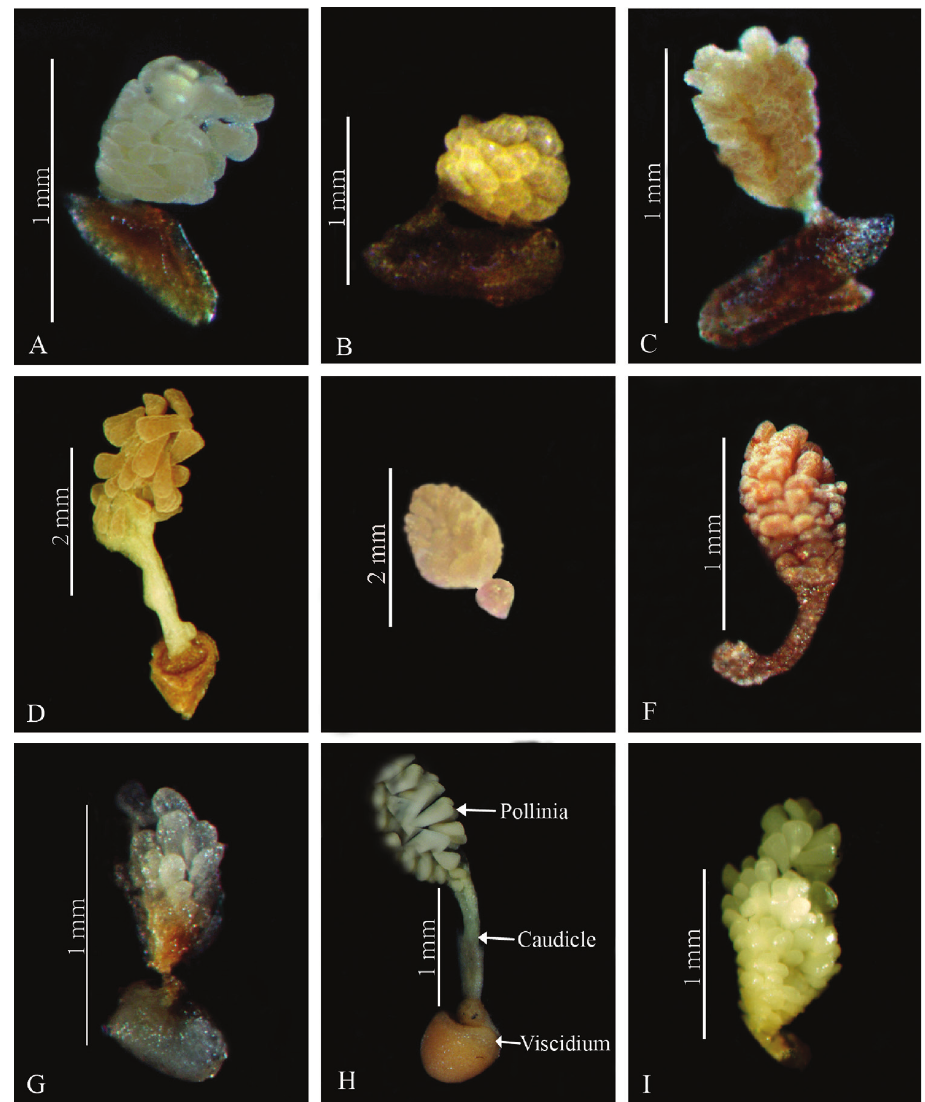
Figure 11. Pollinia structure in Herminium. A H. josephi B H. macrophyllum C H. pygmaeum D H. handelii E H. lanceum F H. fallax G H. forceps H H. latilabre I H. coeloceras . Spur: Lacking in most of the species, but a significant minority have a spurred lip ( H. alaschanicum , H. albomarginatum , H. albosanguineum , H. albovirens , H. bulleyi